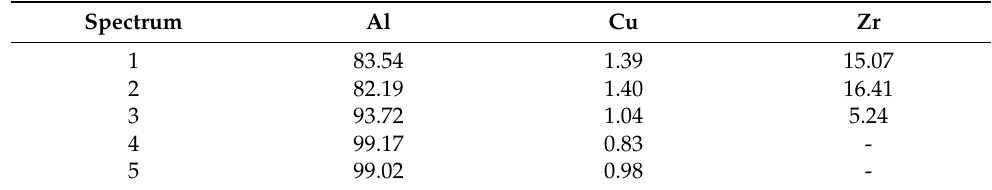
Figure 7. STEM images and EDX analysis of the large precipitates in Aloy-II aged at 400 °C for 900 h. ( a ) The areas that were analyzed by EDX microanalysis are indicated; ( b ) Al (red) and Zr (green) element line-scan profiles and line-scan plots of number of counts versus distance recorded. Table 2. Semi-quantitative EDX microanalysis of the phases indicated in Figure 7a (in atomic%).